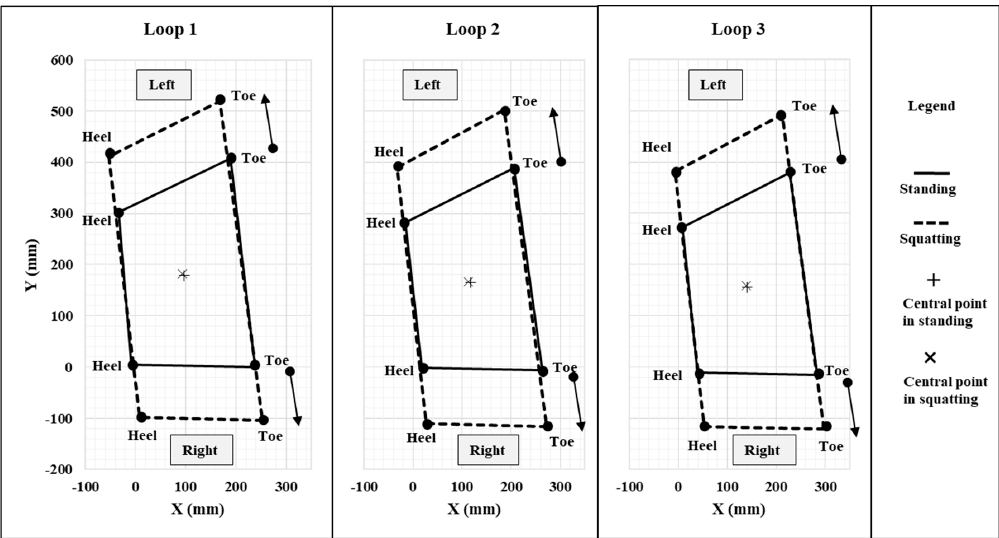
Figure 13. Illustration of the change of Xsens-based BOS in a Standing-Full Squatting motion (Task 11). Note: Central points in standing (+) and in squatting (×) are largely overlapped. Sensors 2017 , 17 , 2091